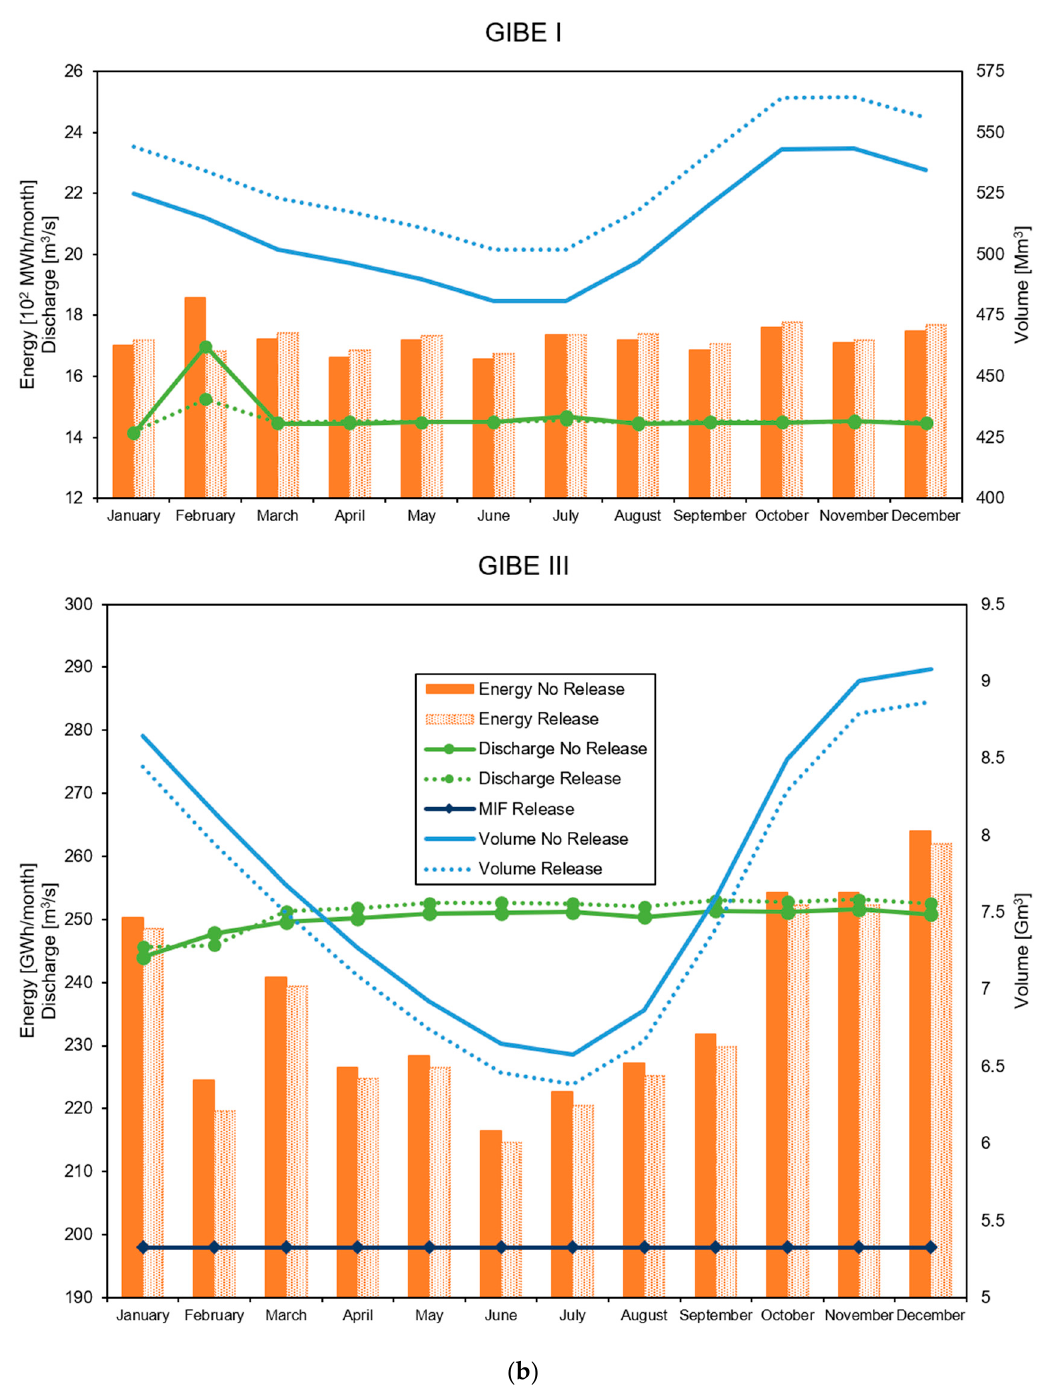
Figure 4. Mean monthly potential hydropower productions, discharge release, and water volumes stored in the reservoir during CR (2010–2019), with No Release (S1, solid lines), and Environmental Release (S2, dotted lines). ( a ) GERD and ( b ) GIBE.